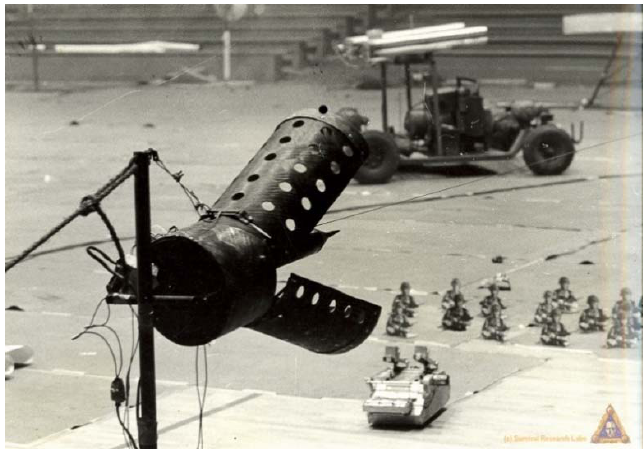
Figure 3. Scene from Terrifying Scenes from The Battlefields of Tomorrow , a mechanical performance by SRL, 6 December 1980, Kezar Pavillion, San Francisco. © Survival Research Labs (www.srl.org).